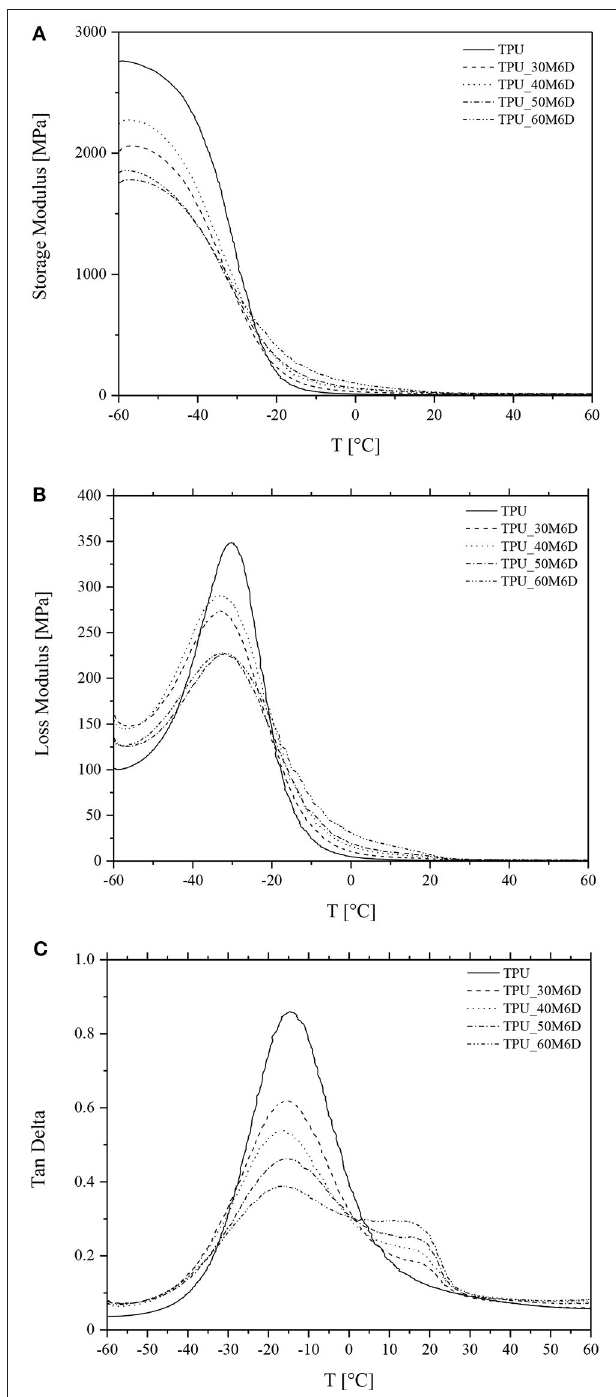
FIGURE 5 | Results of DMTA tests on neat TPU and relative blends. (A) Storage modulus, (B) loss modulus and (C) loss tangent.